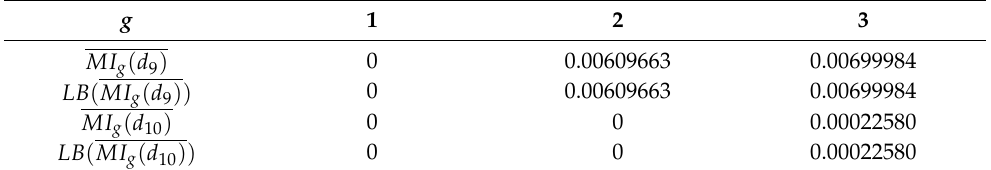
Table 5. Numerical results of Example